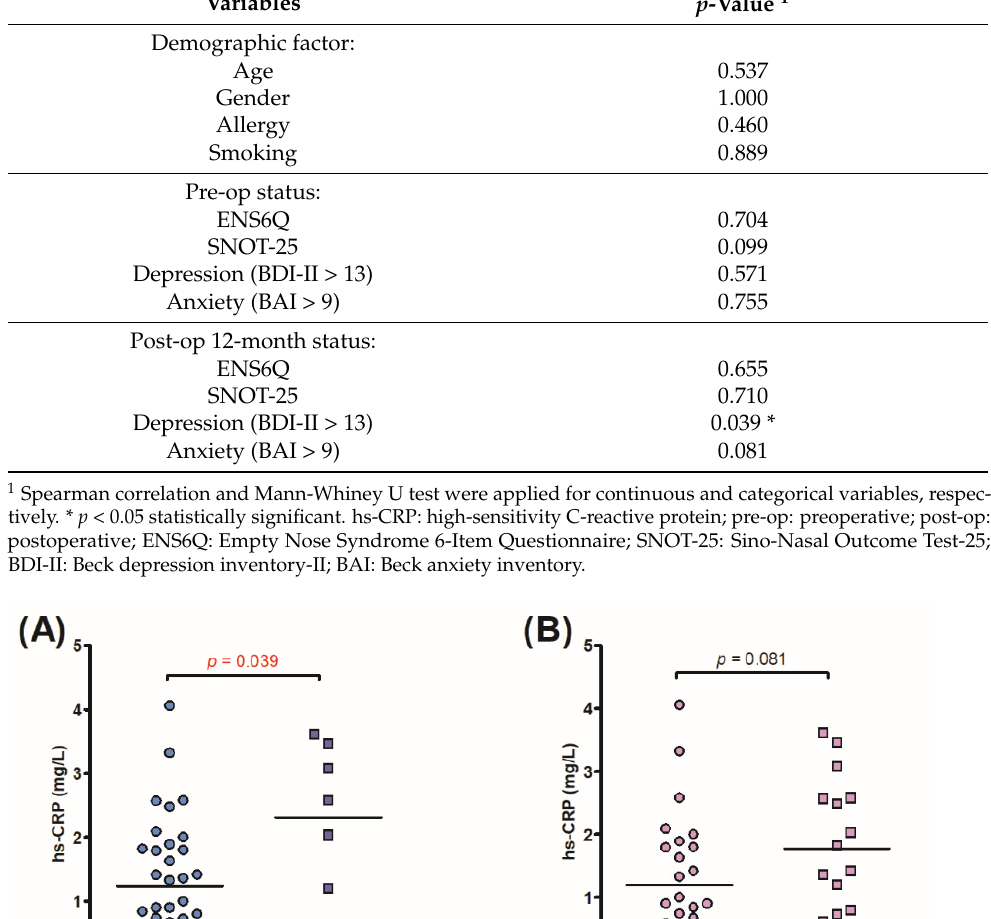
Table 2. Correlation between the preoperative hs-CRP level and other parameters.